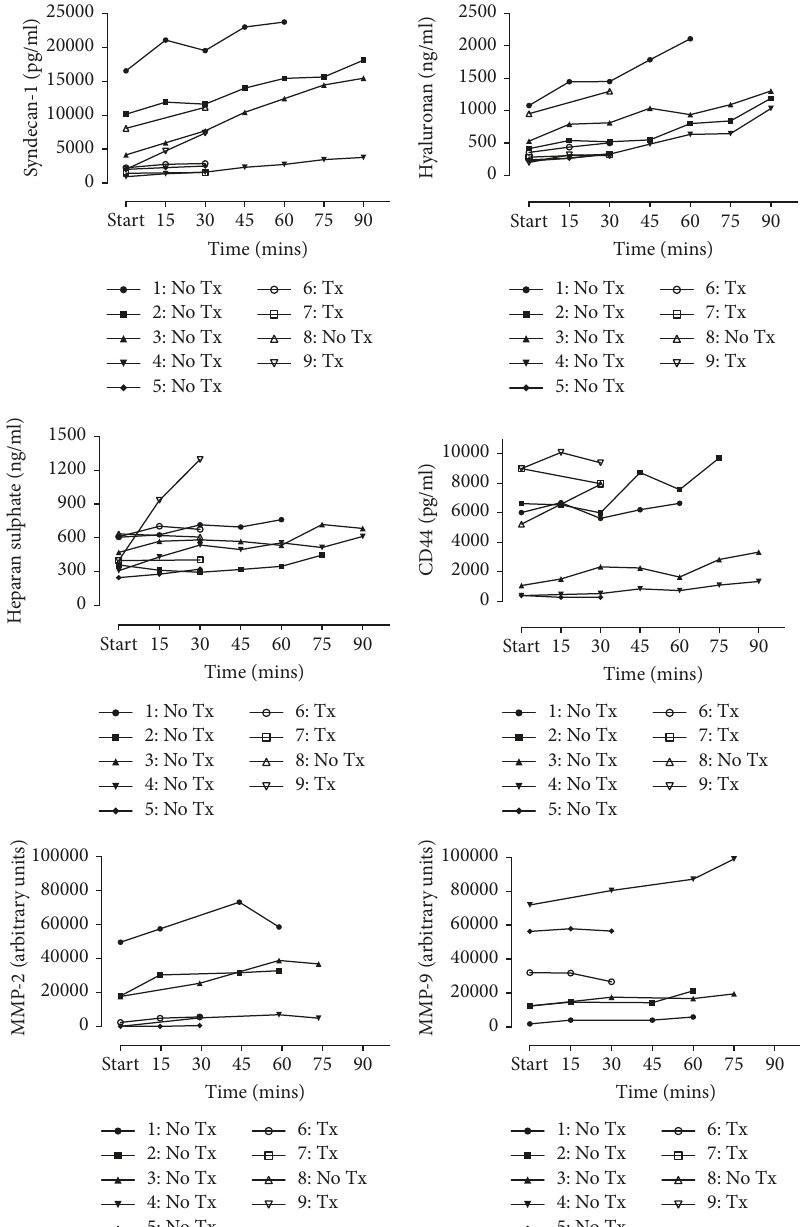
Figure 2: Perfusate levels of endothelial glycocalyx breakdown products and matrix metalloproteinases (MMPs) over time during human ex vivo lung perfusion (EVLP). The start time point varied for lungs and is detailed in Table 1. Lungs 1–4 were experimental lungs that underwent prolonged perfusion. Tx: lungs transplanted after EVLP; No Tx: lungs not transplanted after EVLP; pg/ml: pictograms per ml; ng/ml: nanograms per